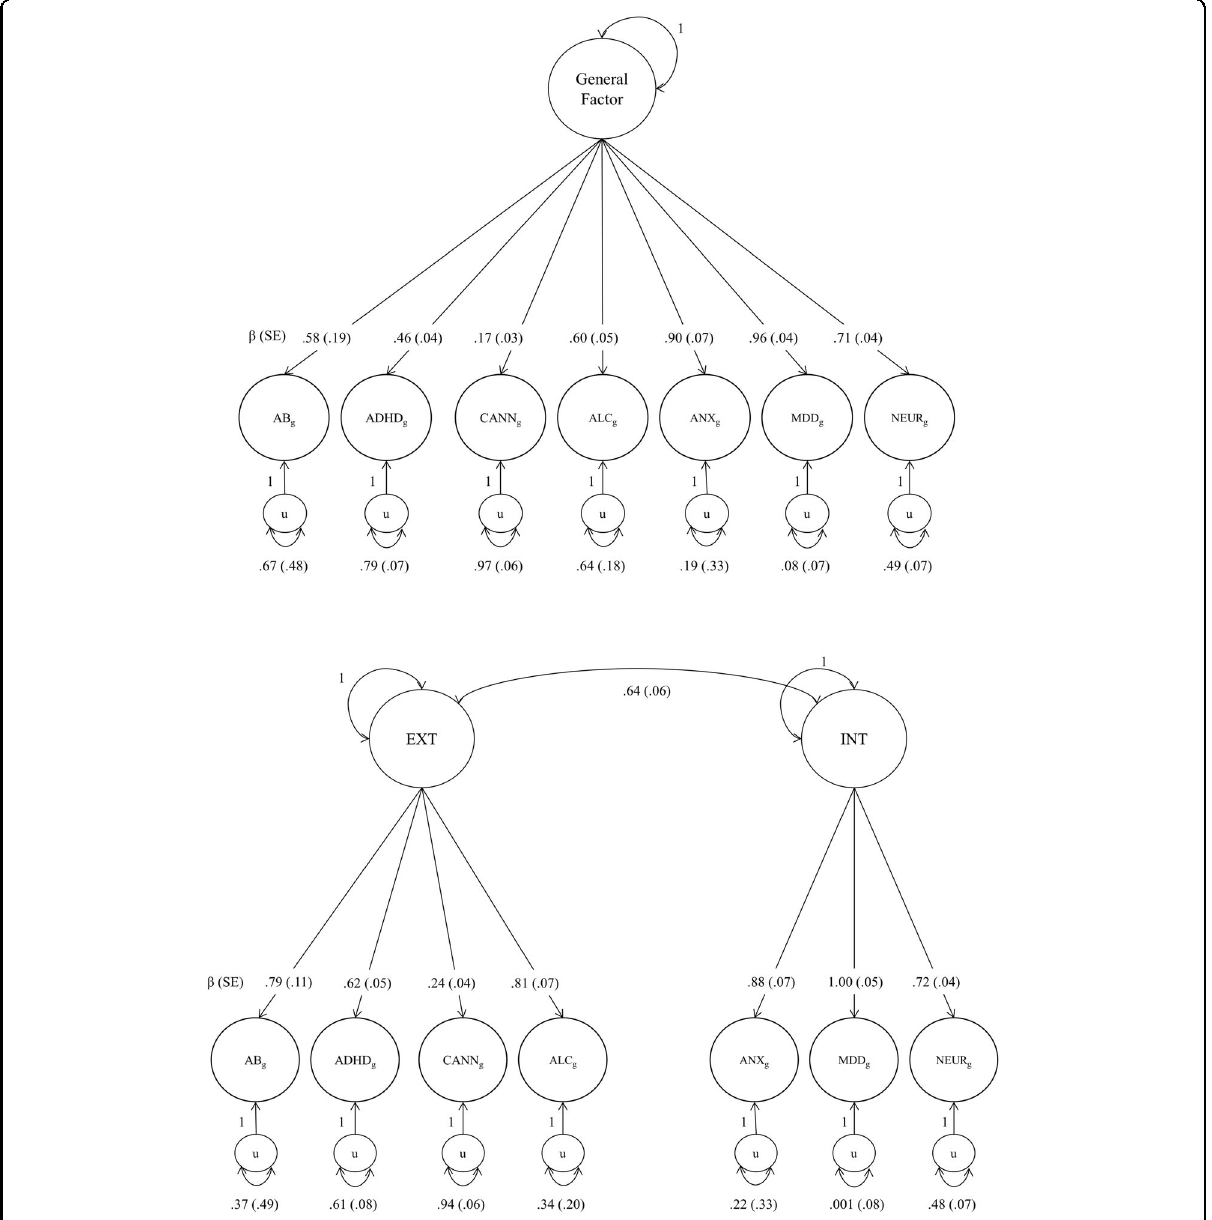
Fig. 4 Genomic SEM one-factor and two-factor model. Con fi rmatory factor analyses were conducted on the GWAS summary statistics in Table 1, using the Genomic SEM package in R Statistical Software (Grotzinger et al., 2019). Standardized estimates are shown. See Supplemental Fig. 3 for unstandardized estimates. In both the one-factor and two-factor models, the residual variance of MDD was fi xed to zero. Model fi t comparisons between the one-factor model ( χ ²(14) = 76.762, p < 0.001, AIC = 104.762, CFI = 0.962, SRMR = 0.127) and two-factor model ( χ ²(13) = 46.072, p < 0.001, AIC = 76.072, CFI = 0.980, SRMR = 0.084) indicated superior model fi t of the two-factor model ( Δ χ ² = 30.69(1), p < 0.001, Δ CFI > 0.01, lower AIC). Single-nucleotide polymorphism effects were then integrated into the model to derive new SNP weights for the construction of latent polygenic scores (see Supplemental